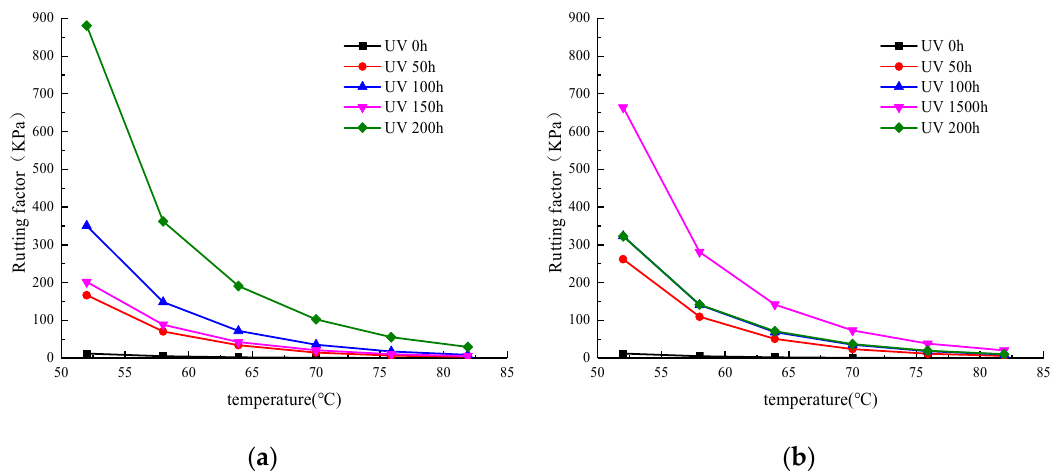
Figure 7. Rutting factor of WMA. ( a ) Oxygen isolation conditions. ( b ) Oxygen-containing conditions. Figure 7b is a temperature-sweep curve of the rutting factor of SK WMA with 0.5% Evotherm at various temperatures after UV aging at di ff erent times under aerobic conditions. As the figure shows, the rutting factor increased with the aging time within 150 h. However, with the aging time of 200 h, the rutting factor declined, and its curve was similar to that when the UV aging time was 100 h. This di ff ered significantly from the rutting factor after aging at di ff erent times under the oxygen isolation condition. Although the rutting factor was larger under the oxygen isolation condition than under the aerobic conditions with UV aging for 200 h, it was slightly lower under the oxygen isolation condition than under aerobic conditions within 100 h of UV